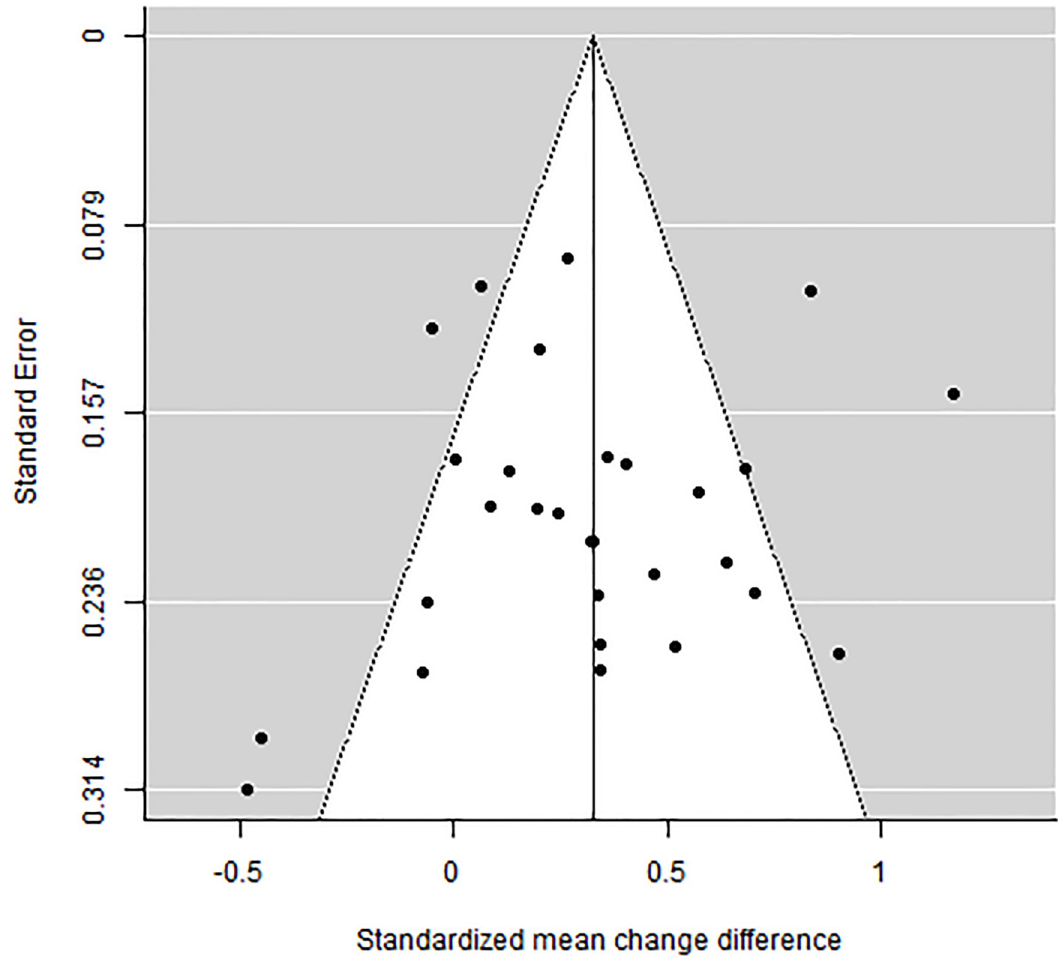
Fig 3. Funnel plot of the 29 standardized mean change difference indices for